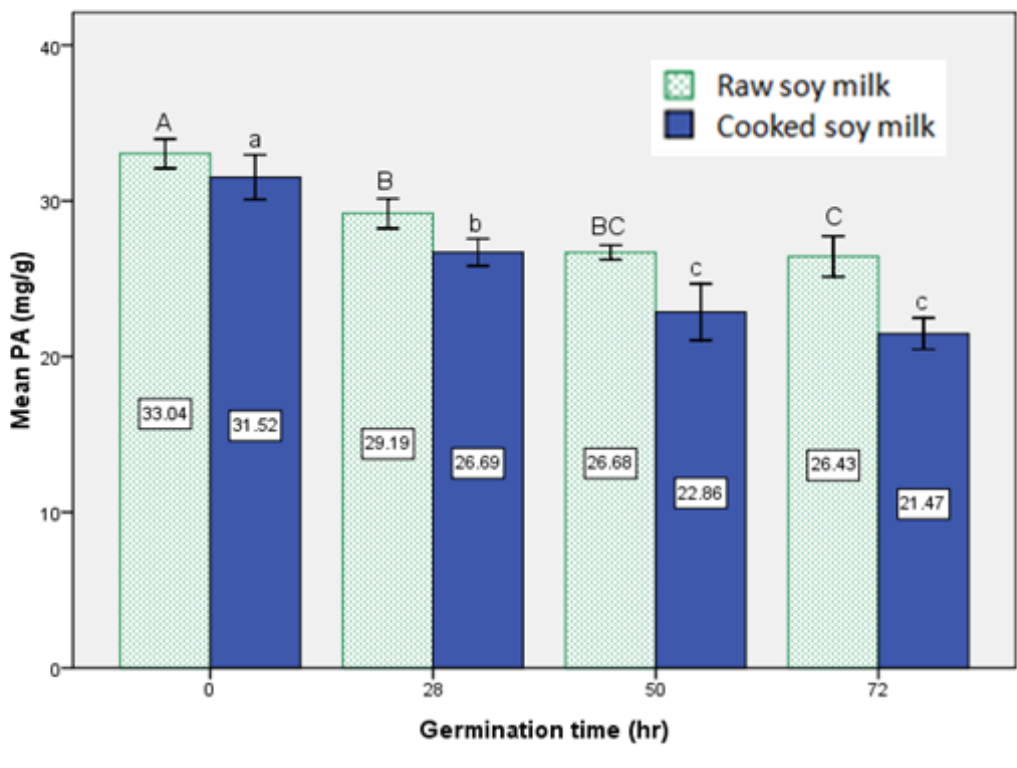
Figure 2. Effect of different germination time on phytic acid content of soy milk. Bar data are expressed as the mean ± standard deviation ( n = 3). Bars marked with the same capital letters indicate no significant ( p < 0.05) differences among the raw soy milks, and bars marked with the same small case letters indicate no significant ( p < 0.05) differences among the cooked soy